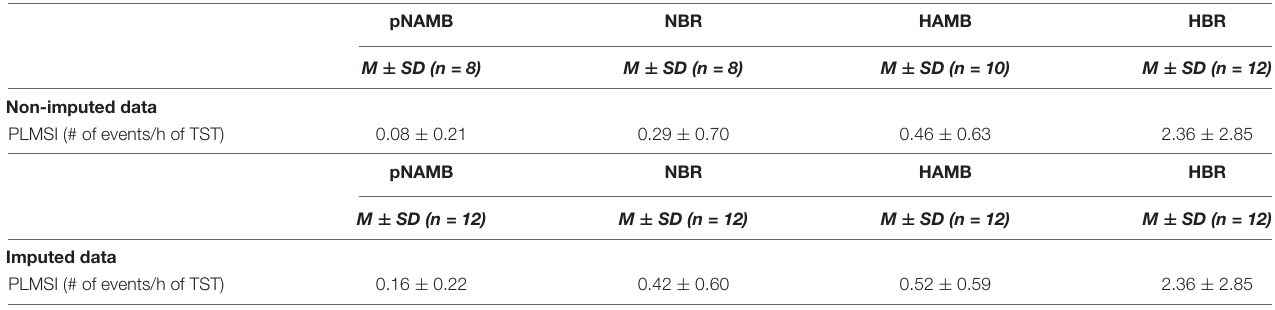
TABLE 5 | Overview of periodic leg movement outcomes in each level of both independent variables (i.e., activity and PO 2 ). pNAMB NBR HAMB HBR M ± SD (n = 8) M ± SD (n = 8) M ± SD (n = 10) M ± SD (n = 12)